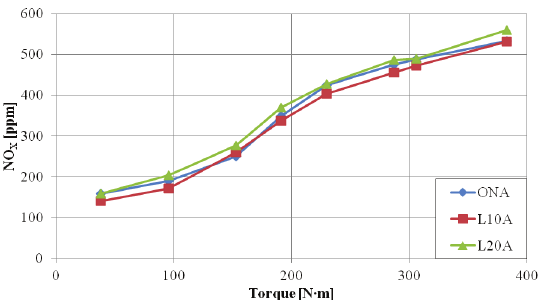
Fig. 8. NO x concentration for injection timing A and n = 2000 rpm